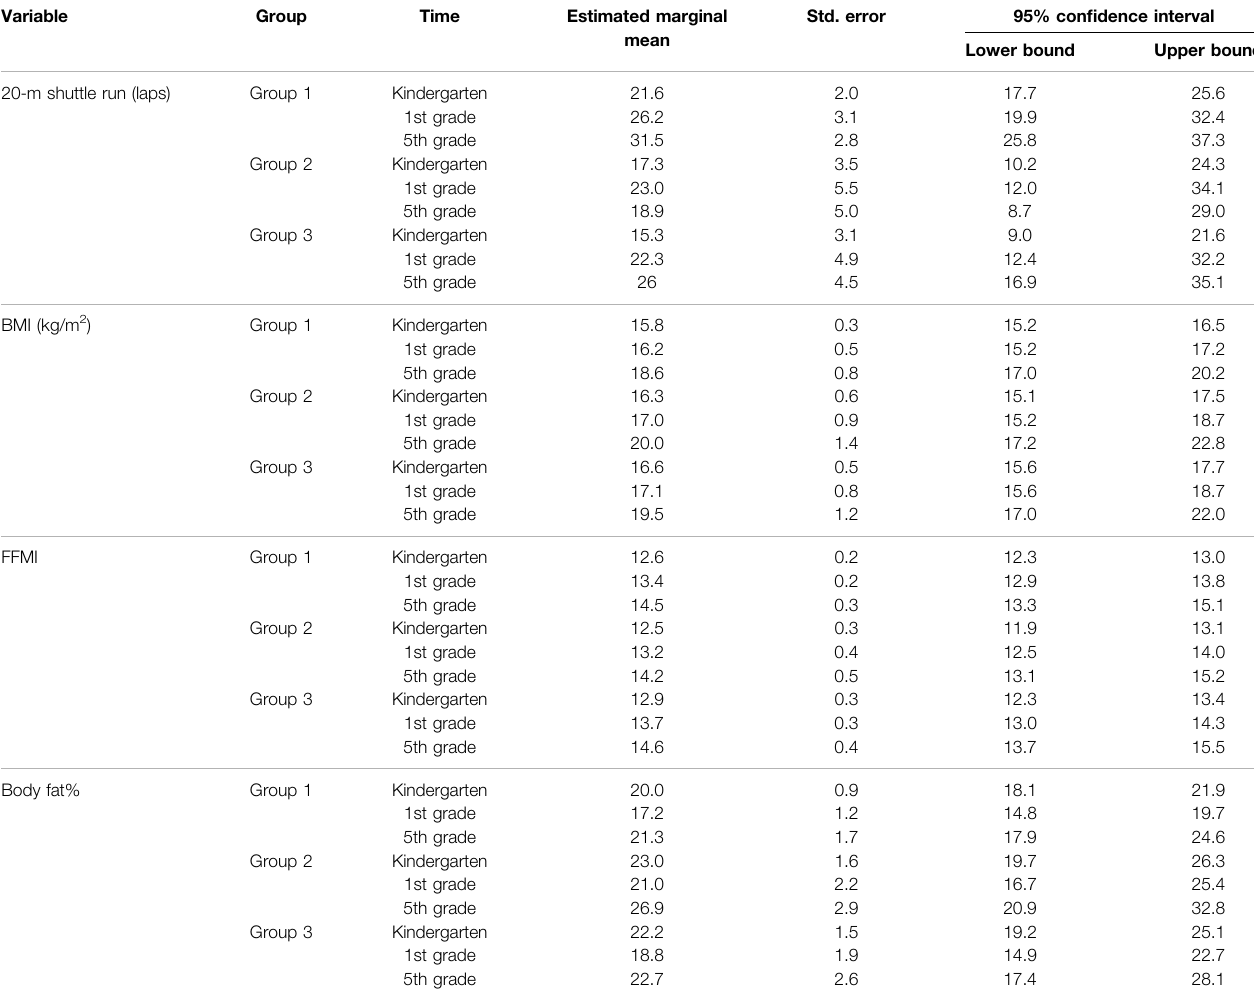
Group 1 — participation in organized sports in all stages of the study. Group 2 — participation in organized sports in 5th grade or in 1st and 5th rades. Group 3 — never participated in organized sports. BMI, body mass index; FFMI, fat-free mass index; body fat %, percentage of body